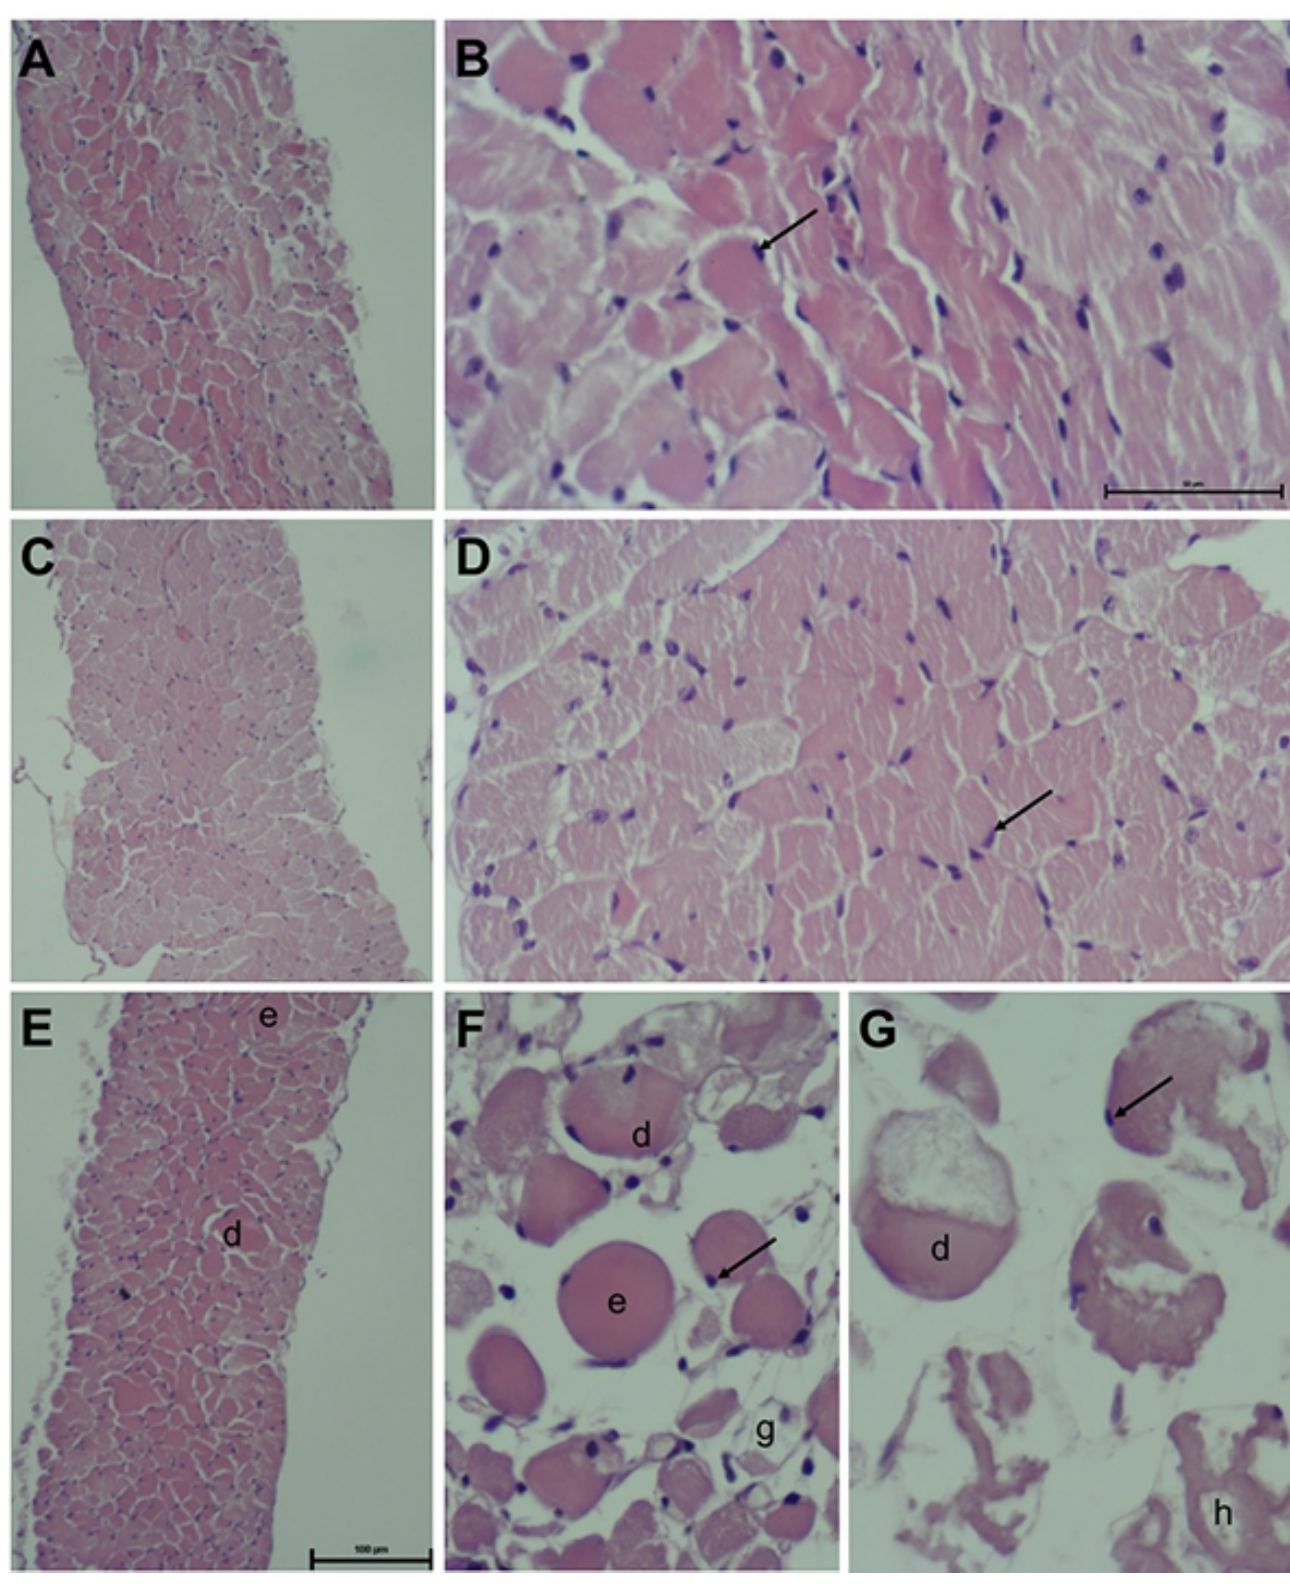
Figure 5. Histological analysis of diaphragm muscles incubated with Tyrode alone and bufotenine. (A, B) Tyrode alone, (C, D) 21 μg/mL of bufotenine and (E-G) 210 μg/mL of butotenine. Observe the normal muscle morphology in Tyrode and bufotenine at lower concentrations. However, myonecrosis can occur at 210 μg/mL of butotenine, as observed in (F) and (G) . d: delta lesion, e: edematous fiber, h: hypercontracted fiber, g: ghost fiber. Magnification: (A, C, E) = 100x; (B, D, F, G) =